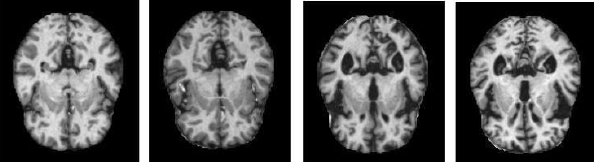
Fig 3.1: MRI Images (ADNI dataset)